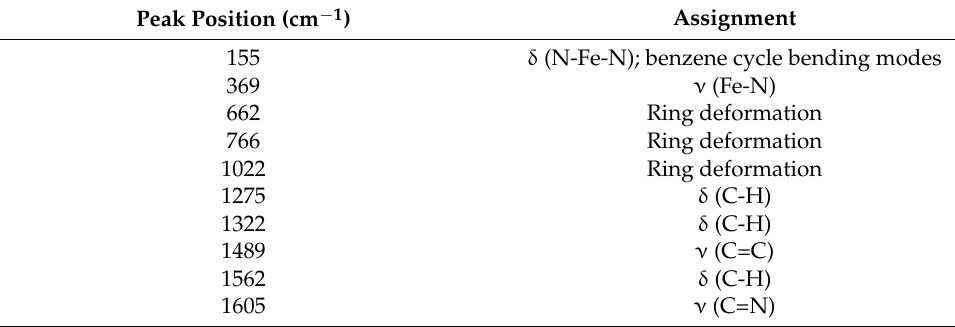
Figure 4. Comparison of the Raman spectra of [Fe(bpy) 3 ] 2+ SO 3 − @SiO 2 film (red, 1) and the Raman spectra of [Fe(bpy) 3 ]SO 4 ● 7.5H 2 O microcrystalline powder (green, 2). Table 2. Identified Raman vibration modes and assignment for [Fe(bpy) 3 ] 2+ SO 3 − @SiO 2